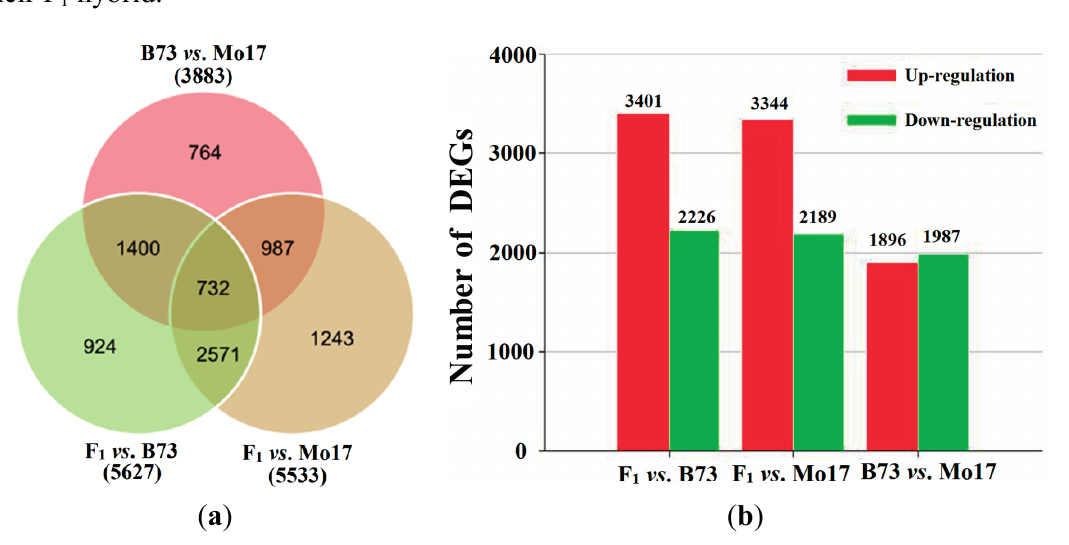
Figure 1. Differentially expressed genes in the maize heterotic cross. Venn diagram ( a ) and statistical analysis ( b ) of differentially expressed genes among inbred parents and their F 1